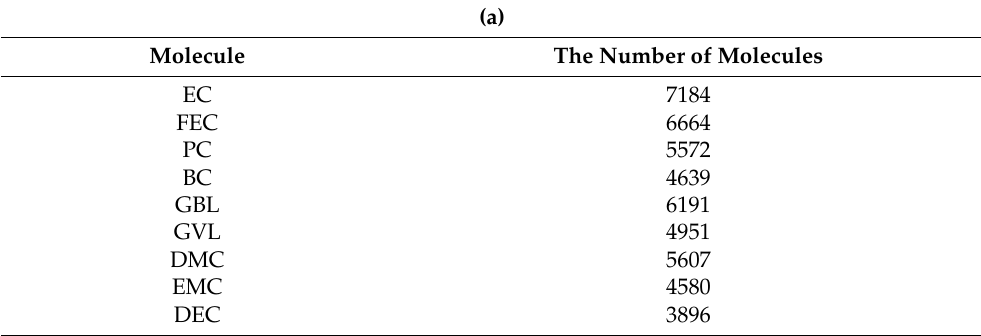
Table 1. Details of the molecular compositions for the electrolyte model. (a) Single solvent of electrolyte solution. (b) Mixed solvents of electrolyte